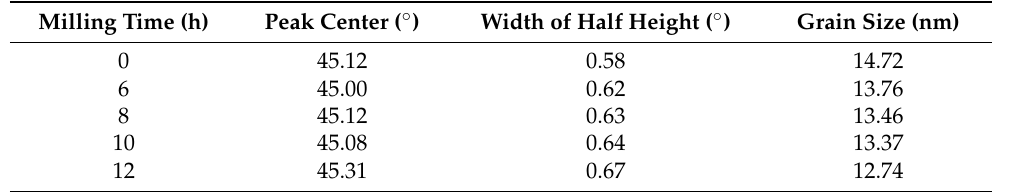
Table 1. Grain size of nanocrystalline alloy with different milling time.